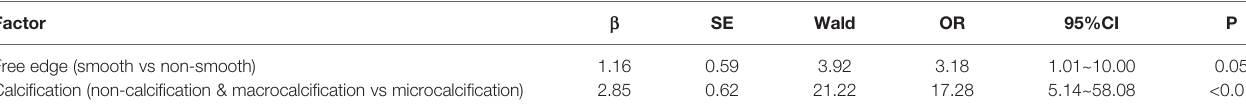
TABLE 3 | Results of Logistic regression analysis of the ultrasound characteristics of partial cystic thyroid nodules. Factor b SE Wald OR Free edge (smooth vs